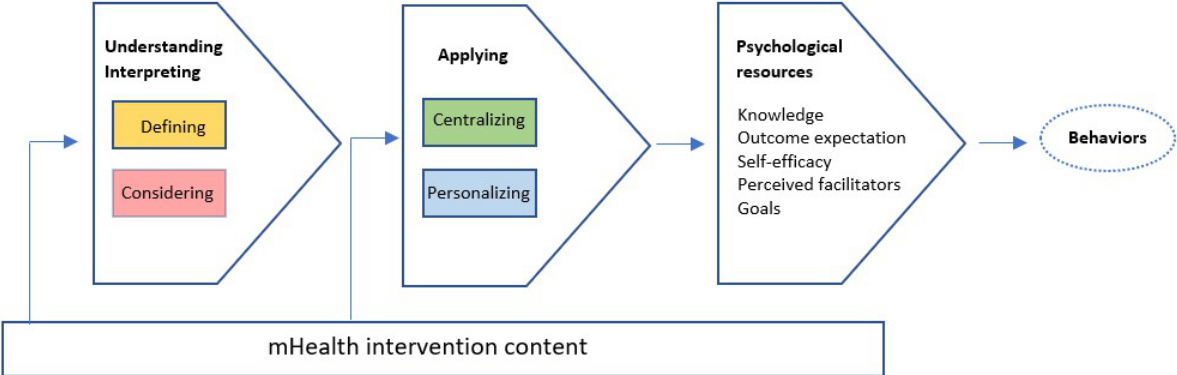
Figure 1. Model illustrating categories influencing end-users’ understanding, interpretation, and application of intervention content, which in turn may determine consequences of engagement.